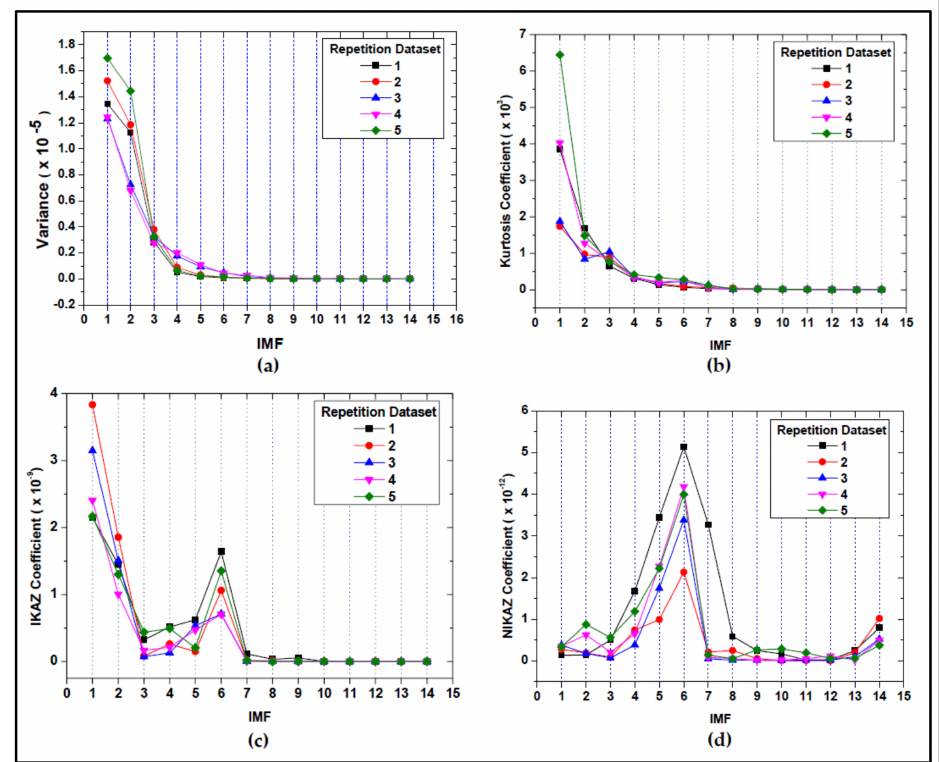
Figure 19. The curve for 5 mm leak IMFs induced on fire hydrant 2 and 3: ( a ) Variance, ( b ) Kurtosis, ( c ) IKAZ, ( d )